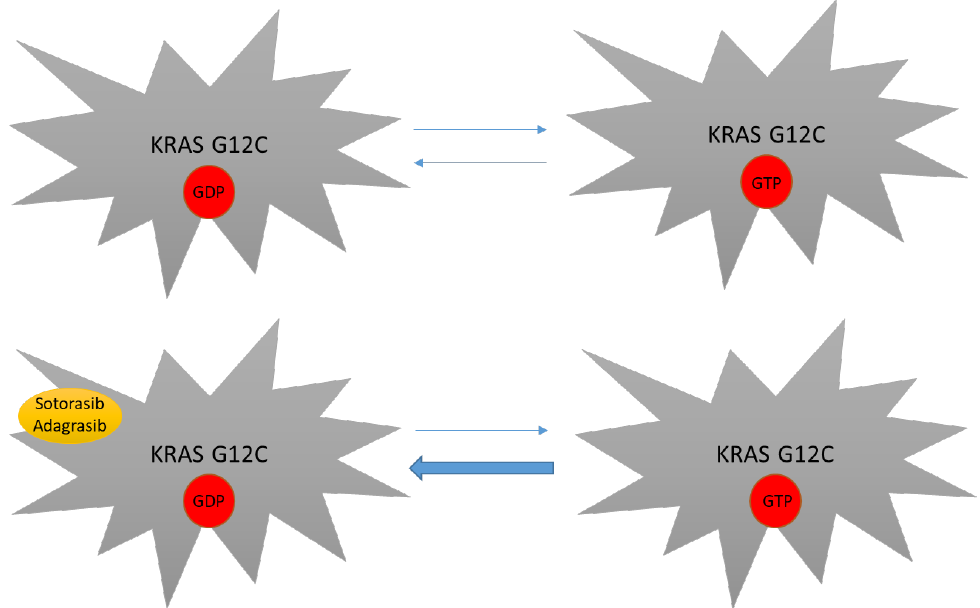
Figure 2. Mechanism of action of novel KRAS inhibitors. KRAS G12C mutants still depend on their GTP binding state in order to be fully active. By covalently binding the switch pocket II, sotorasib and adagrasib reduce KRAS G12C-GDP availability, thus impairing transition to the KRAS-GTP active form.